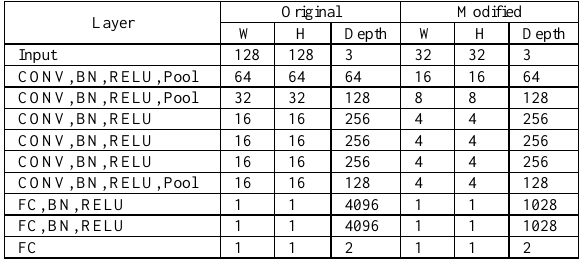
Table 4. A small modification of Deep CNNs architecture in terms of width, height and depth of the layers.